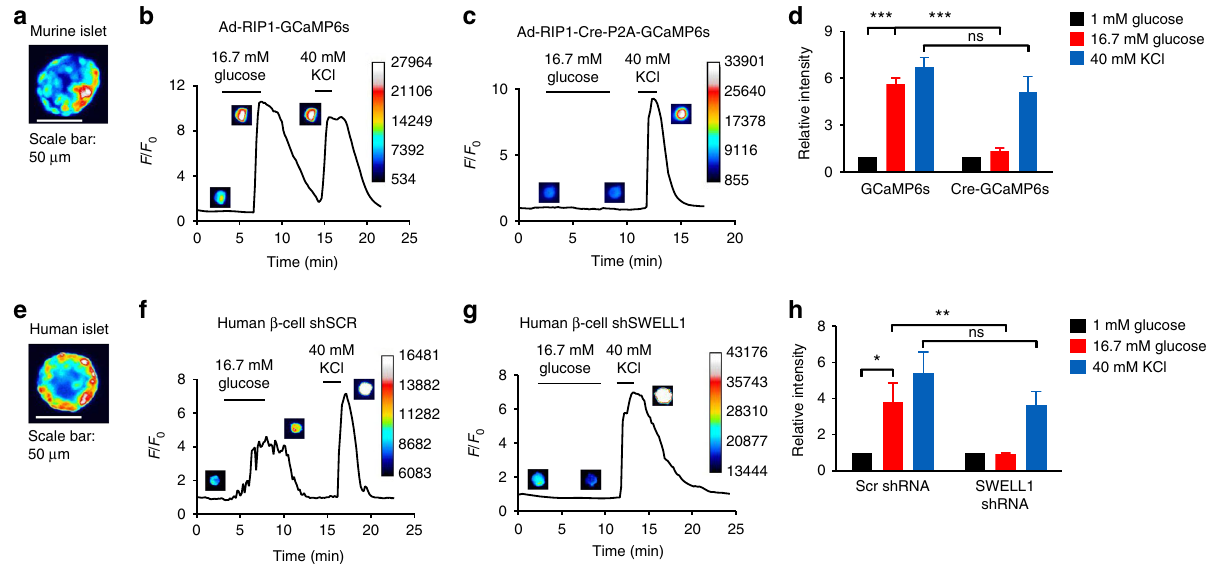
Fig. 5 SWELL1 - mediated I Cl,SWELL is required for glucose-stimulated Ca 2+ signaling in primary β -cells. a Ad-RIP1-GCaMP6s-transduced Swell1 fl / fl murine islet. Scale bar represents 50 µ m. b – d GCaMP6s Ca 2+ transients in WT ( b , Ad-RIP1-GCaMP6s/ Swell1 fl / fl ) and SWELL1 KO ( c , Ad-RIP1-Cre-P2A- GCaMP6s/ Swell1 fl / fl ) primary murine β -cells in response to 16.7 mM glucose stimulation (basal 1 mM glucose) and 40 mM KCl stimulation. Insets show β - cell fl uorescence images at the indicated times in the experiment. d Mean peak values of GCaMP6s Ca 2+ transients from Ad-RIP1-GCaMP6s/ Swell1 fl / fl ( n = 14 cells) and Ad-RIP1-Cre-P2A-GCaMP6s/ Swell1 fl / fl ( n = 10 cells). e Ad-RIP1-GCaMP6s-transduced human islet. Scale bar represents 50 µ m. f – h GCaMP6s Ca 2+ transients in human primary β -cells co-transduced with Ad-RIP1-GCaMP6s+Ad-shSCR-mCherry ( f ) and Ad-RIP1-GCaMP6s+Ad-sh Swell1 - mCherry ( g ) in response to 16.7 mM glucose stimulation (basal 1 mM glucose) and 40 mM KCl stimulation. h Mean peak values of GCaMP6s Ca 2+ transients from shSCR ( n = 6 cells) and sh Swell1 ( n = 8 cells) transduced human β -cells. Data are shown as mean ± s.e.m. One-way ANOVA for in-group comparison, unpaired t -test for between-group comparison. * p < 0.05, ** p < 0.01, *** p < 0.001. ns, not signi fi